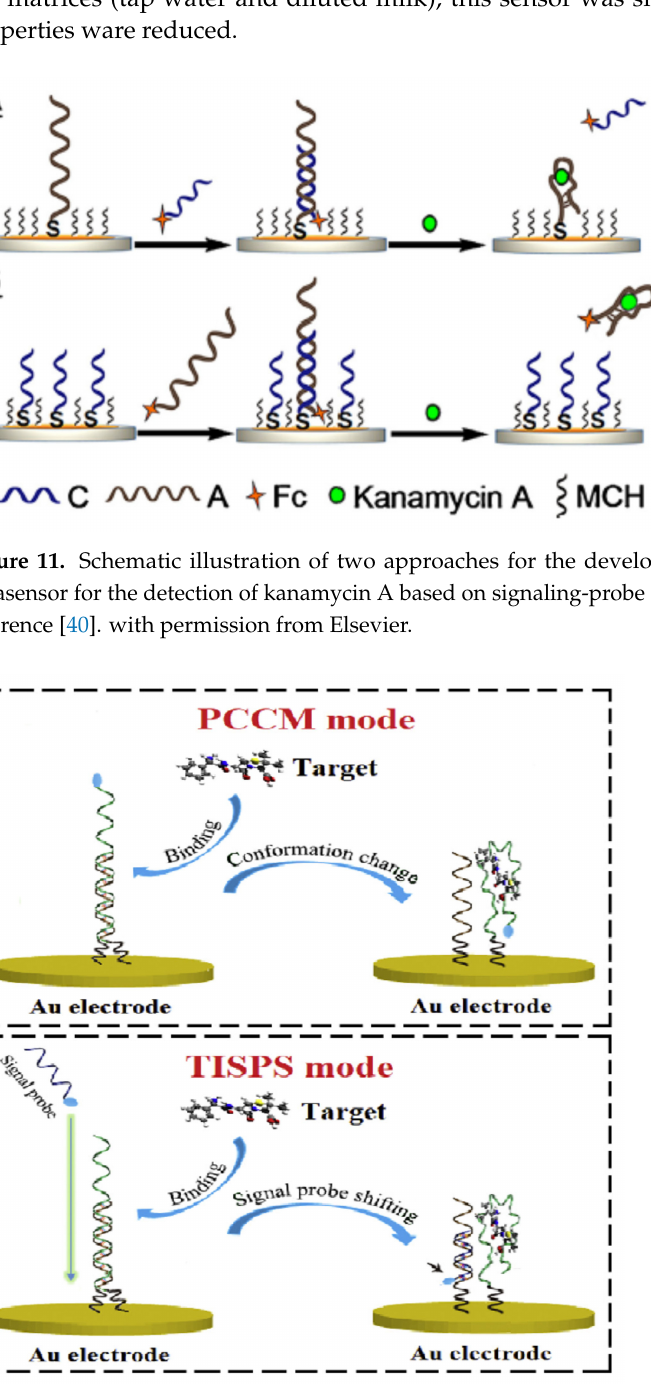
Figure 12. Two electrochemical aptasensors for the detection of kanamycin using two different signal transduction mechanisms: probe conformation changing mode (PCCM) and target-induced signal probe shifting (TISPC). Reprinted from reference [41] with permission from